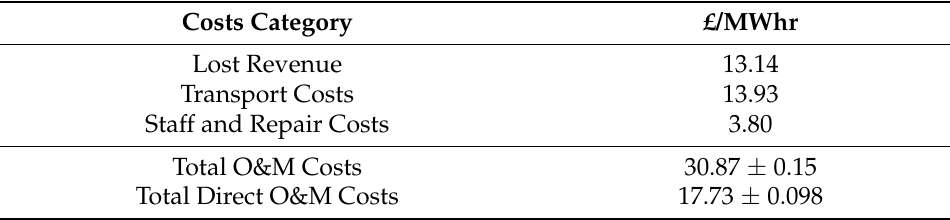
Table 5. Baseline costs